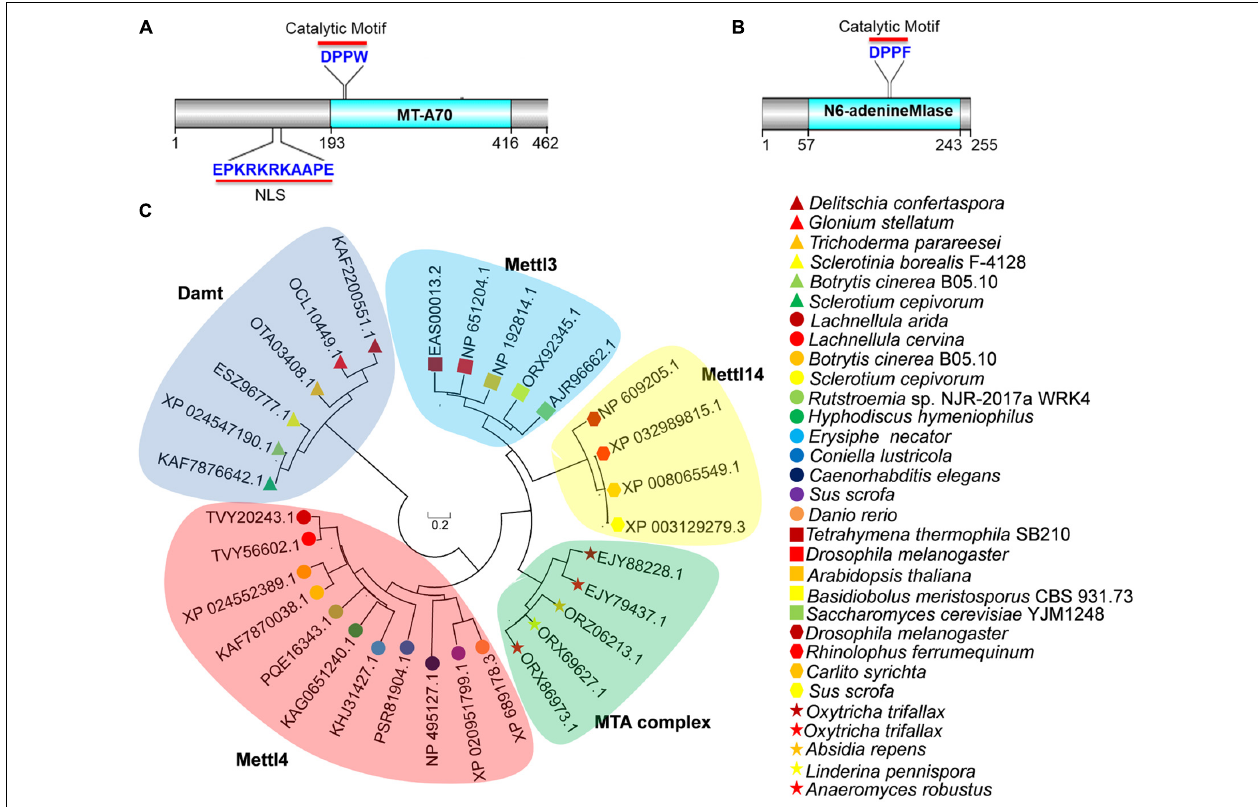
FIGURE 1 | Bioinformatics analysis of BcMettl4 and BcDamt. (A) The structural domains encoded by BCIN_12g06440. (B) The structural domain encoded by BCIN_02g05970. (C) Phylogenetic tree of methyltransferase orthologs based on a neighbor-joining